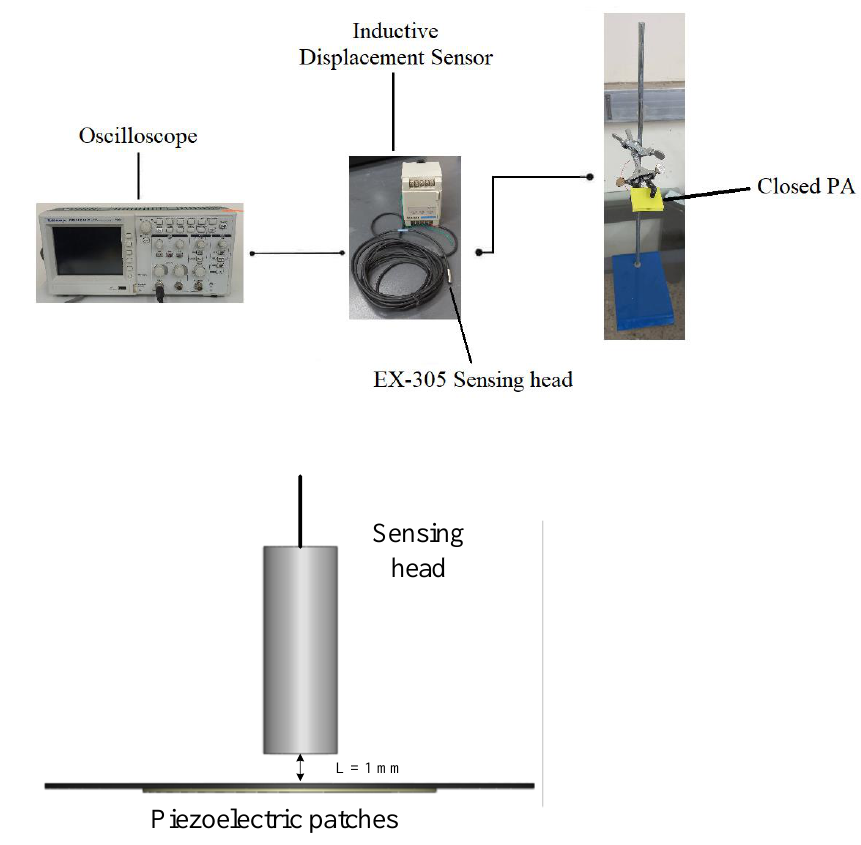
Figure 6. Schematic diagram of the jet path.